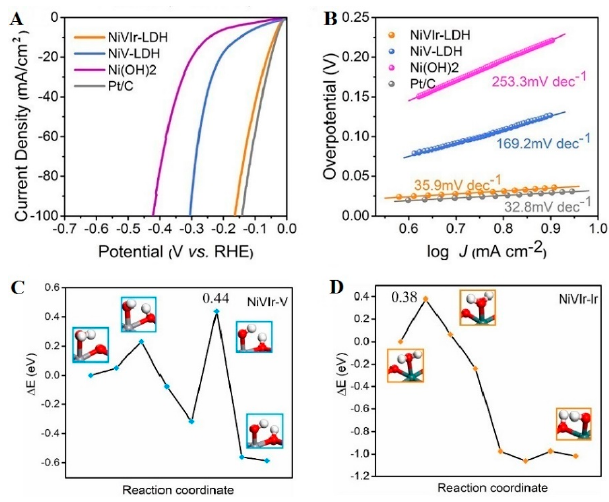
Figure 3. ( A ) Polarization curves and ( B ) Tafel slopes of Ni(OH) 2 , NiV-LDH, NiVIr-LDH, and Pt/C. Water dissociation barriers on ( C ) V and ( D ) Ir sites in NiVIr (reprinted with permission from ref [22]. Copyright © 2019, American Chemical Society).